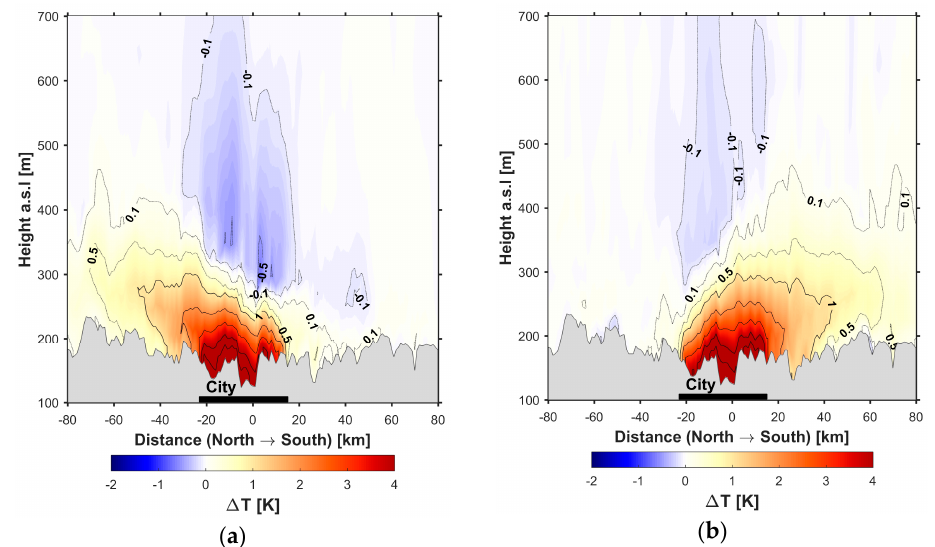
Figure 6. Vertical meridional cross-sections through the center of Moscow in the field of the modeled temperature response to switching on the urban canopy model ( ∆ T ), averaged over the selection of nocturnal (0–1 UTC/3–4 MSK) cases with prevailing: southern wind ( a ); and northern wind ( b ). Considered cases are sampled out of selection of days with intensive urban heat island during June–August 2014. Designations are similar to Figure